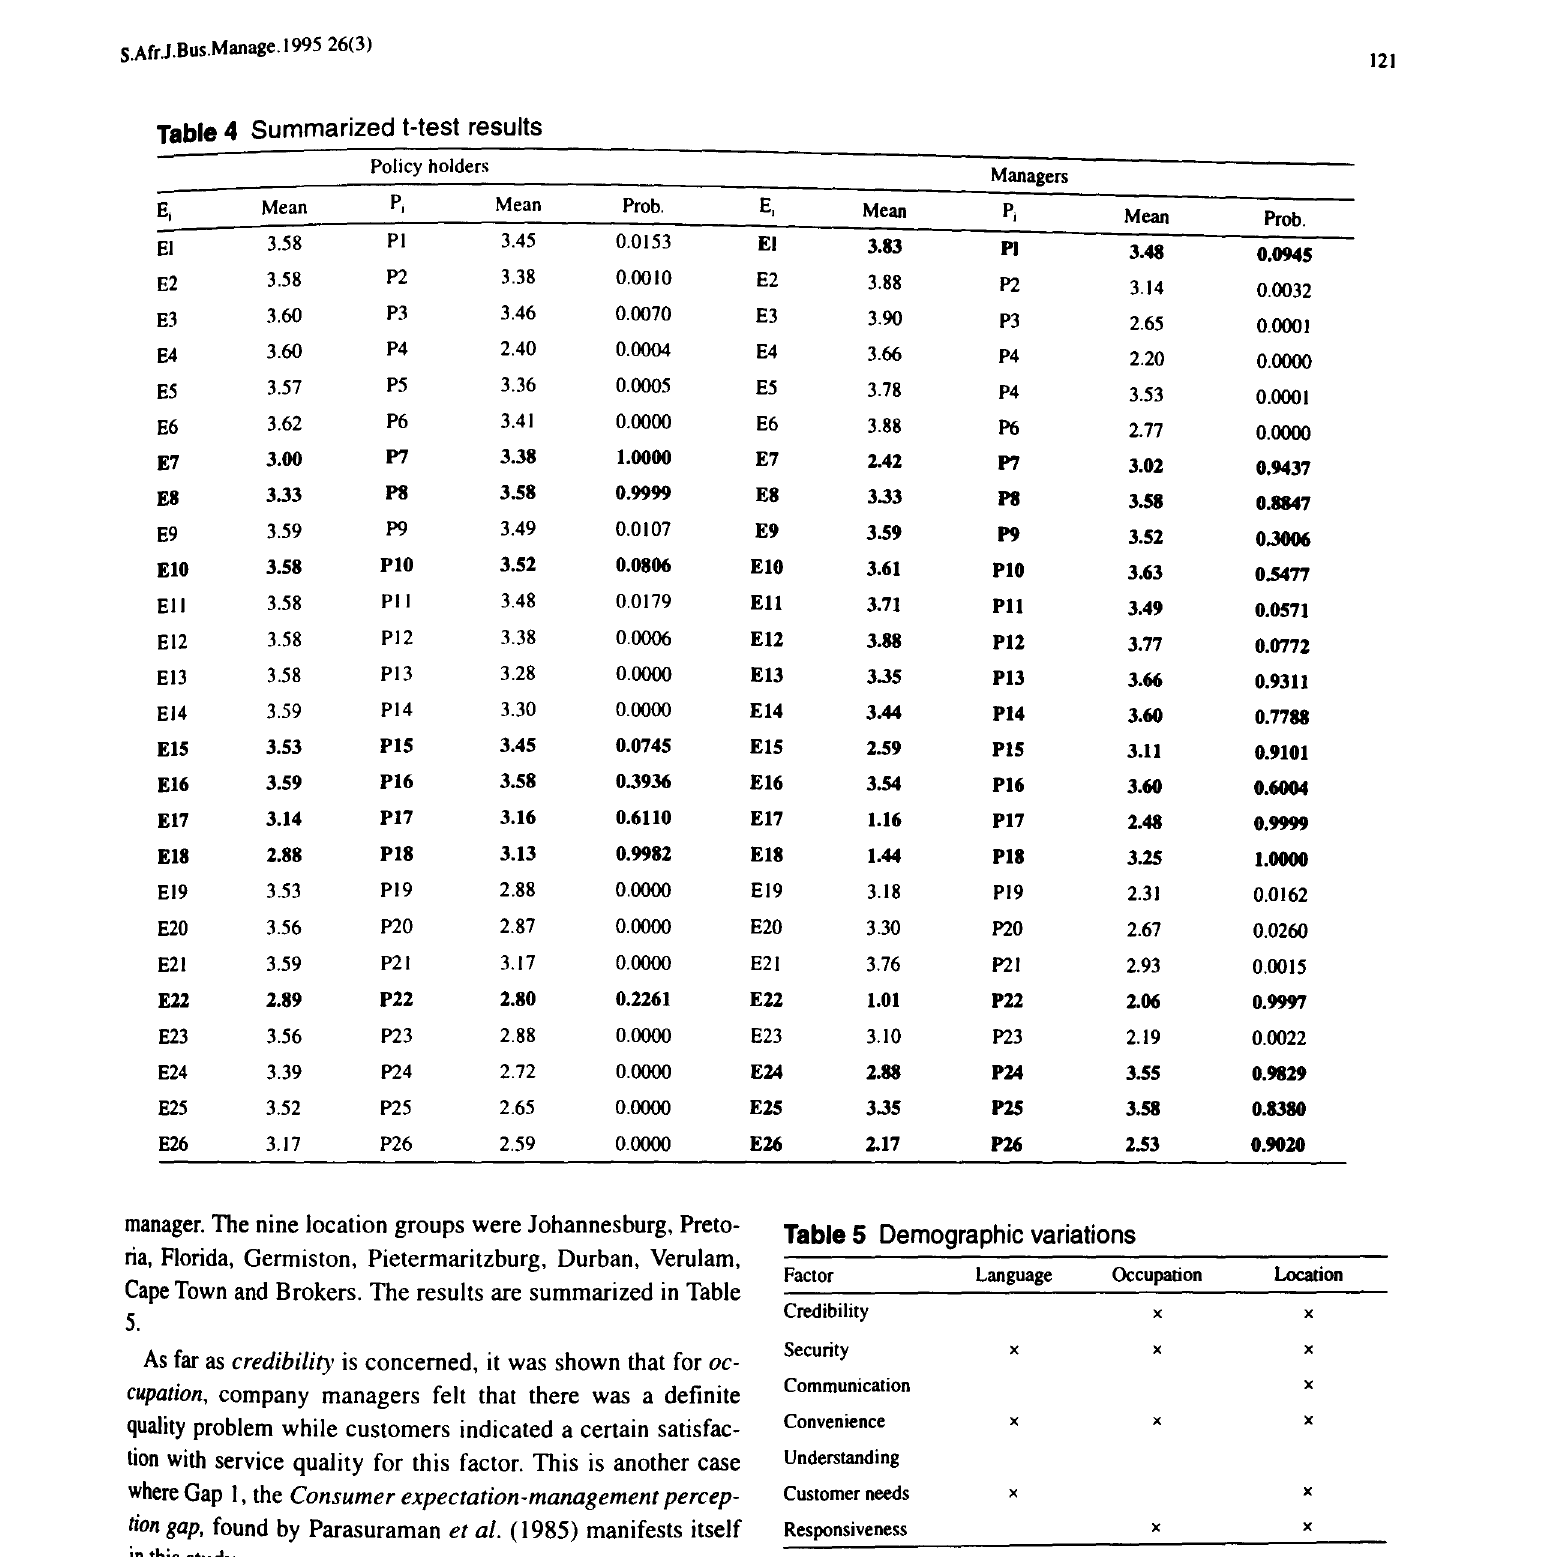
Table 4 Summarized t-test